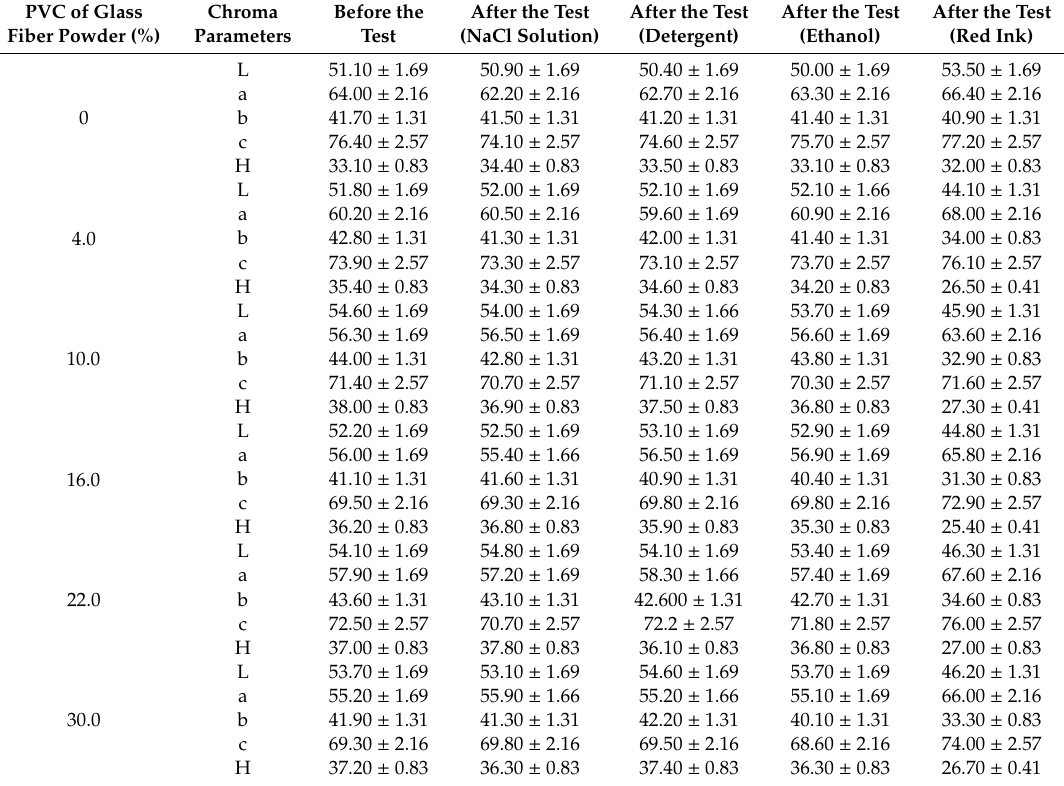
Table 7. Influence of the PVC of glass fiber powder on liquid resistance of the thermochromic waterborne coatings.